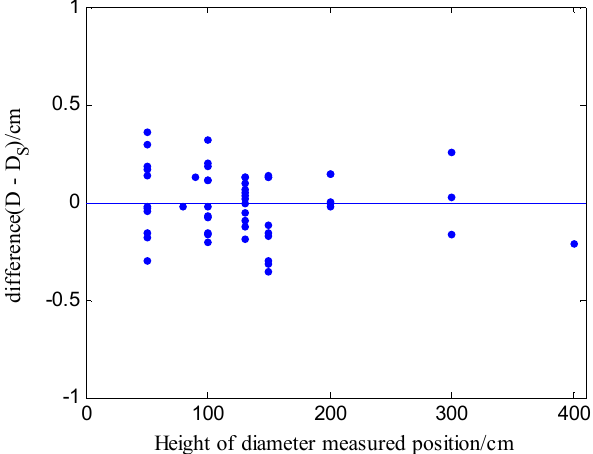
Figure 9. The relationship between the stem height and the diameter difference.